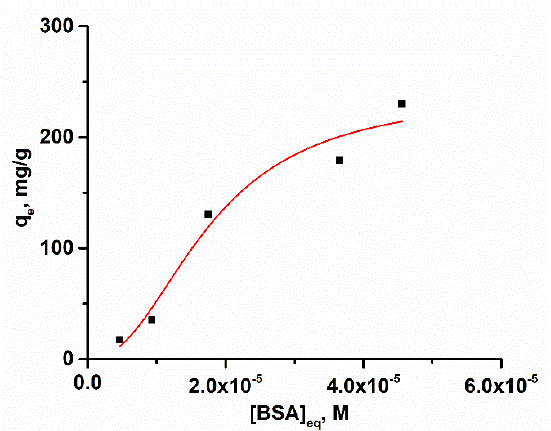
Figure 5. The adsorption isotherm for BSA adsorption on the surface of methionine-coated Ag nanoparticles.